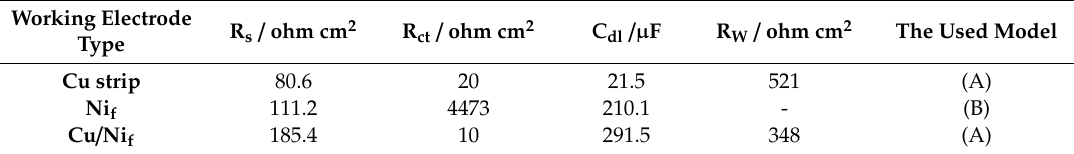
Table 2. Fitting results of impedance spectra for Cu strip, Ni f and Cu / Ni f electrodes recorded in5 mM